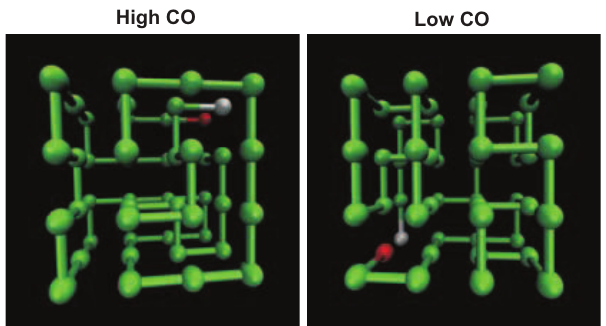
Figure 1. Three-dimensional representation of the lattice proteins that were used to generate the two families of circular permutants with chain length N ~ 48 . Amino acids are represented by beads of uniform size that occupy the lattice vertices; the peptide bond, which covalently connects amino acids along the polypeptide chain, is represented by sticks with uniform (unit) length corresponding to the lattice spacing. The terminal beads are